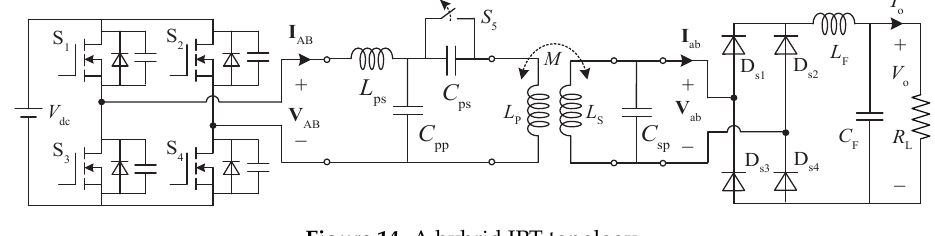
Figure 14. A hybrid IPT topology.